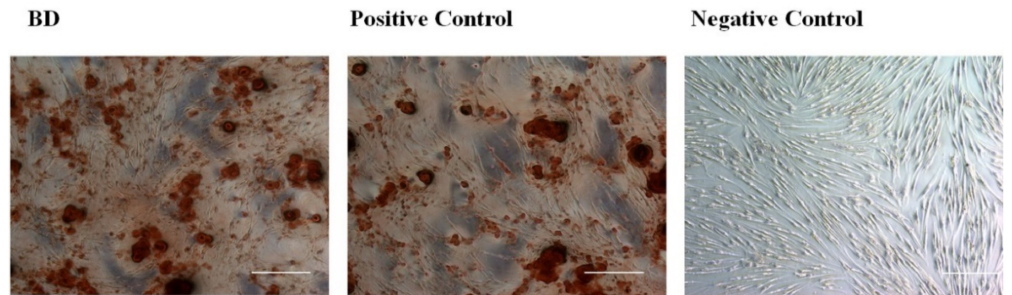
Figure 6. Calcium deposits staining with Alizarin red stain for DPSCs treated with Biodentine, osteogenic differentia- tion media (positive control), and uninduced cells cultured in their own growth media (negative control) after 3 weeks of